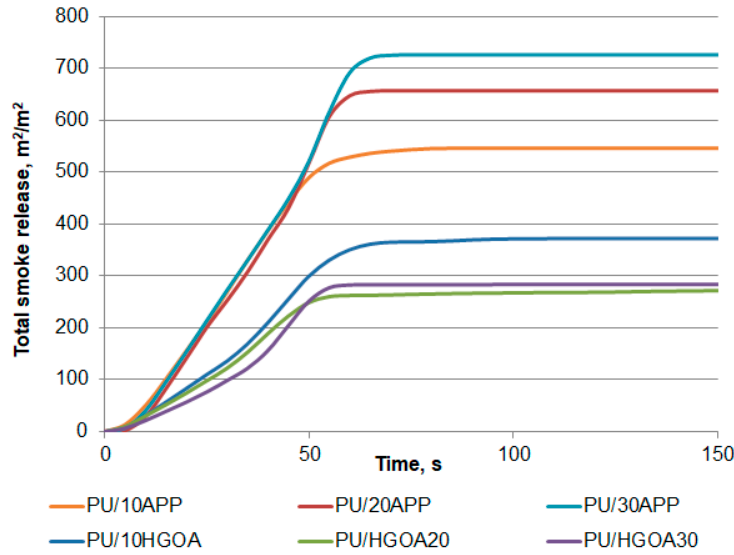
Figure 12. Representative curves of total smoke release of polyurethane foams with APP and HGO A system.